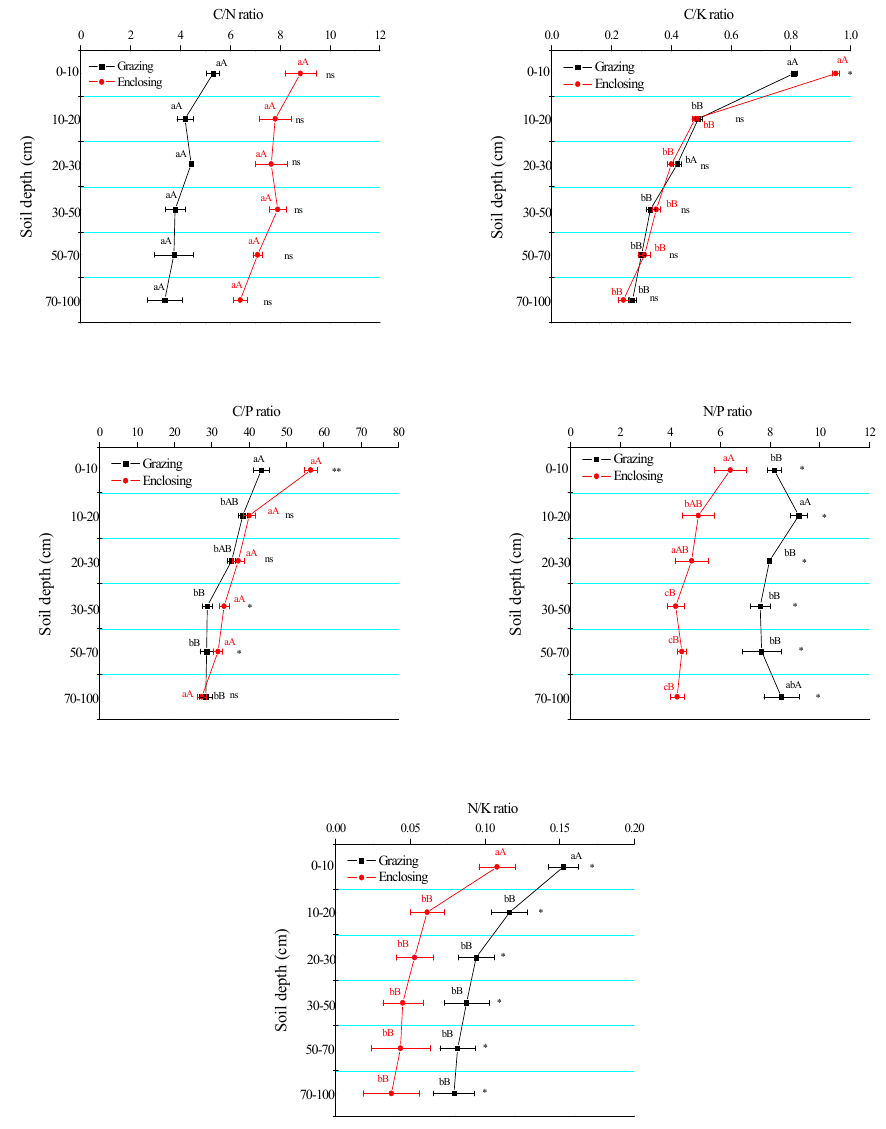
Figure 4. The effects of long term grazing and enclosing on the stoichiometric ratios of soil nutrients. Note: * and ** indicate significant differences at p < 0.05 level and p < 0.01 level of stoichiometric ratios of soil nutrients in each soil layer between the long term grazing plot and the long term enclosing plot and ns indicates no significant difference ( t test). Different lower case and capital letters indicate significant differences at p < 0.05 level and p < 0.01 level of stoichiometric ratios of soil nutrients among different soil layers for long term grazing or long term enclosing by one-way analysis of variance (ANOVA). Error bars were one standard deviation.